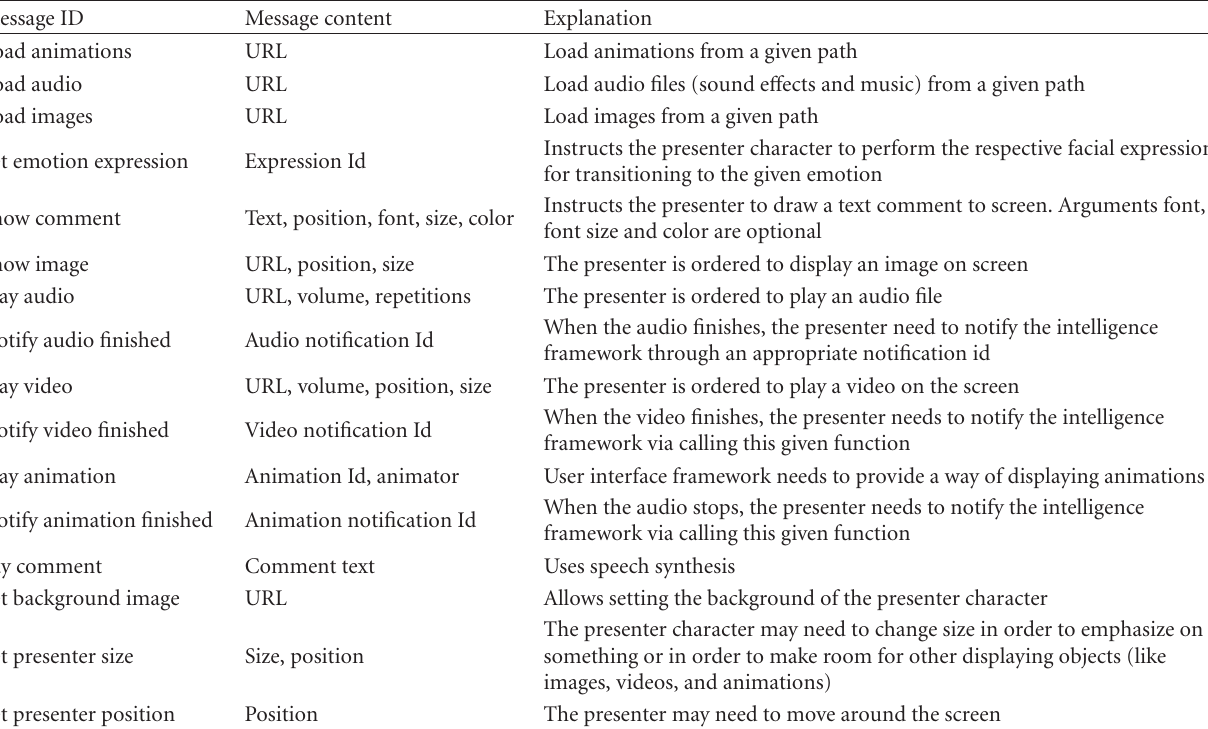
Table 2: A generic communication protocol between the user interface and the Presenter Intelligence